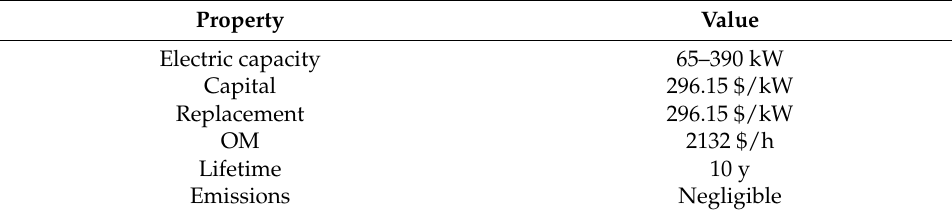
Table A13. Converter parameters [42,43,49].